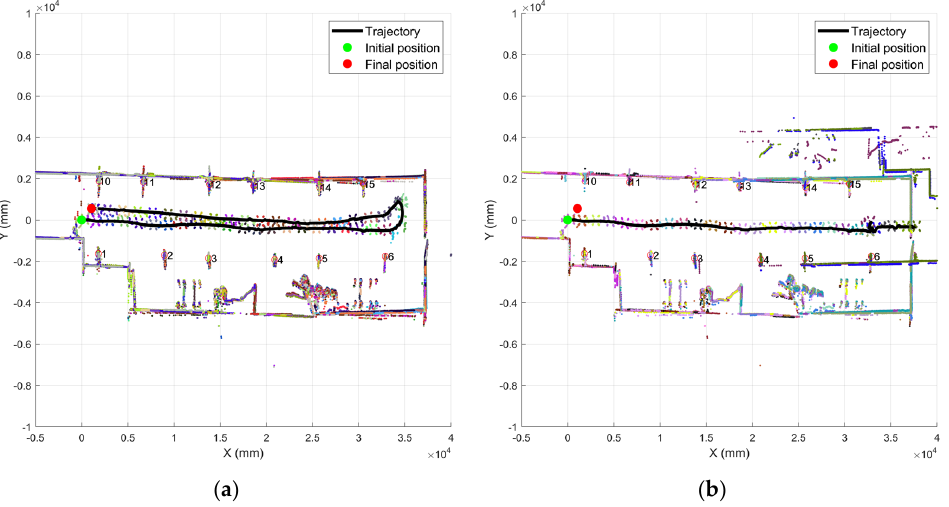
17 of 22 Figure 10. Localization accuracy at different speeds. 3.3. The Influence of Motion Compensation Algorithm on High-Speed Turning Since the navigation system has a motion compensation algorithm to accurately es- timate the position of the robot at the next moment, it can achieve the accurate location